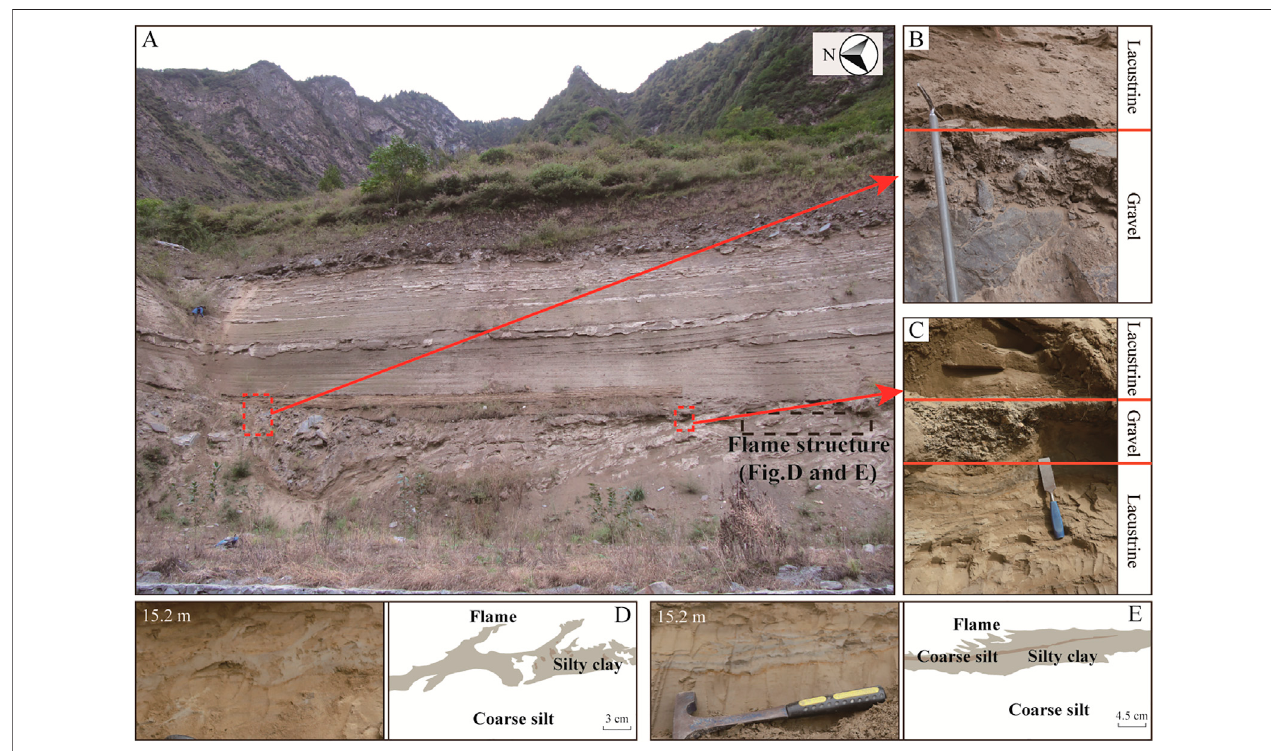
FIGURE5|(A) ThecentralpartofDiexisection; (B) and (C) Lacustrinelayerindirectcontactwiththegravellayer; (D) and (E) SSDlayerapproximately40 cmbelow the gravel layer, showing a typical fl ame